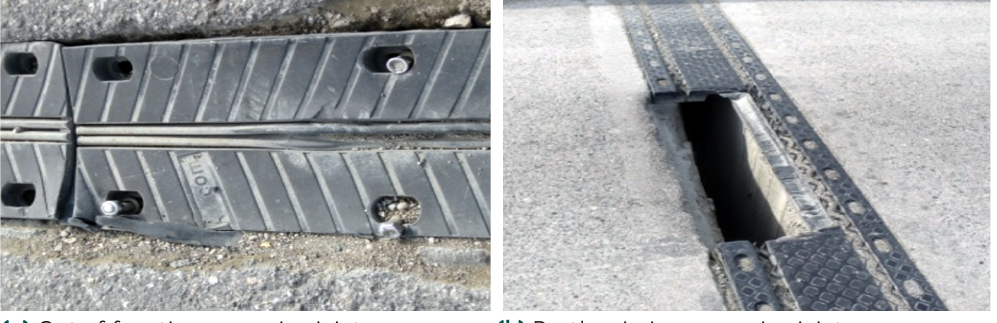
Figure 13. Expansion joint